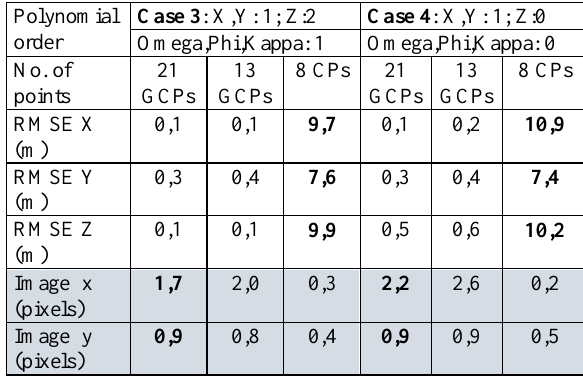
Table 7. Triangulation results,